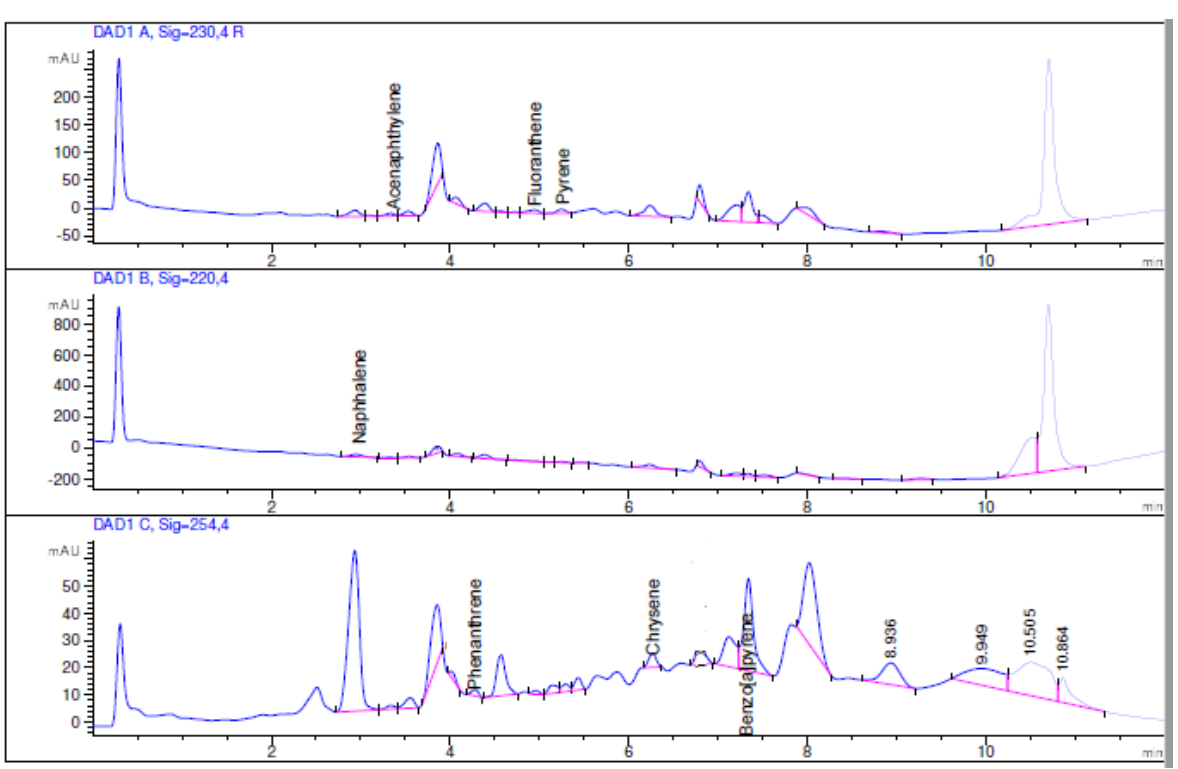
Figure 2. HPLC chromatogram of the spiked bark sample at 1.5 μg g −1 at λ = 230 nm, 220 nm , and 254 nm.